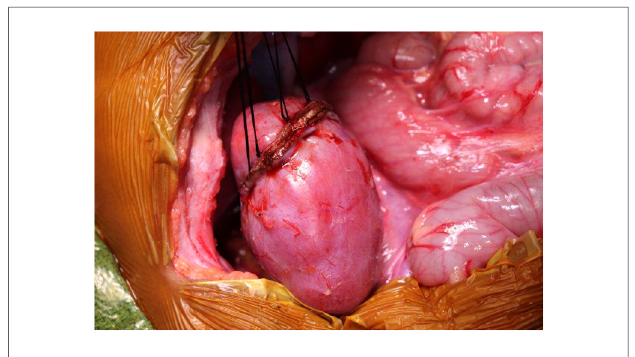
FIGURE 6 Securing the edges of kidney parenchyma folded over a resection defect with silk mattress sutures.